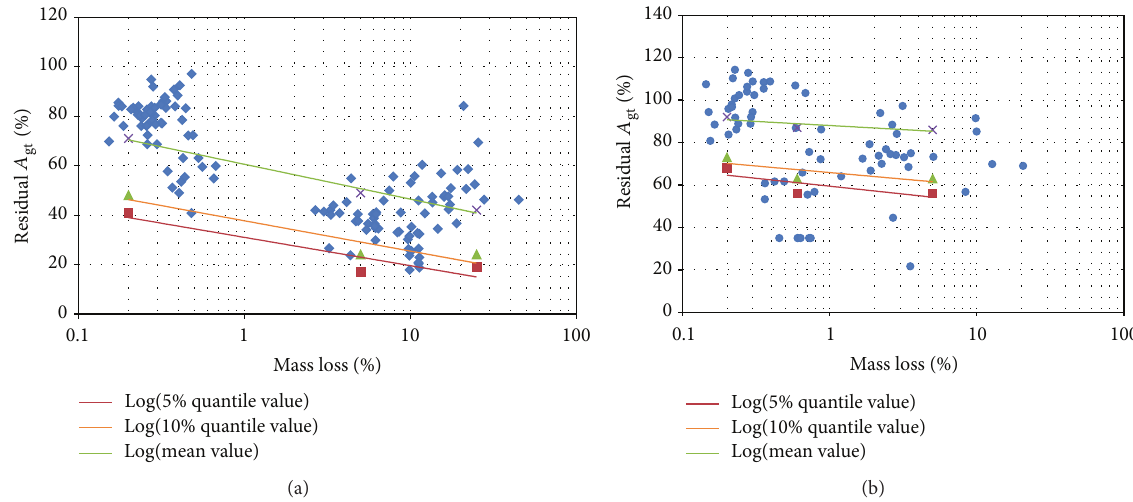
Figure 14: (a) Influence of mass loss on residual 𝐴 for nominal diameter 25 mm (5%, 10%, and 50% residual 𝐴 gt